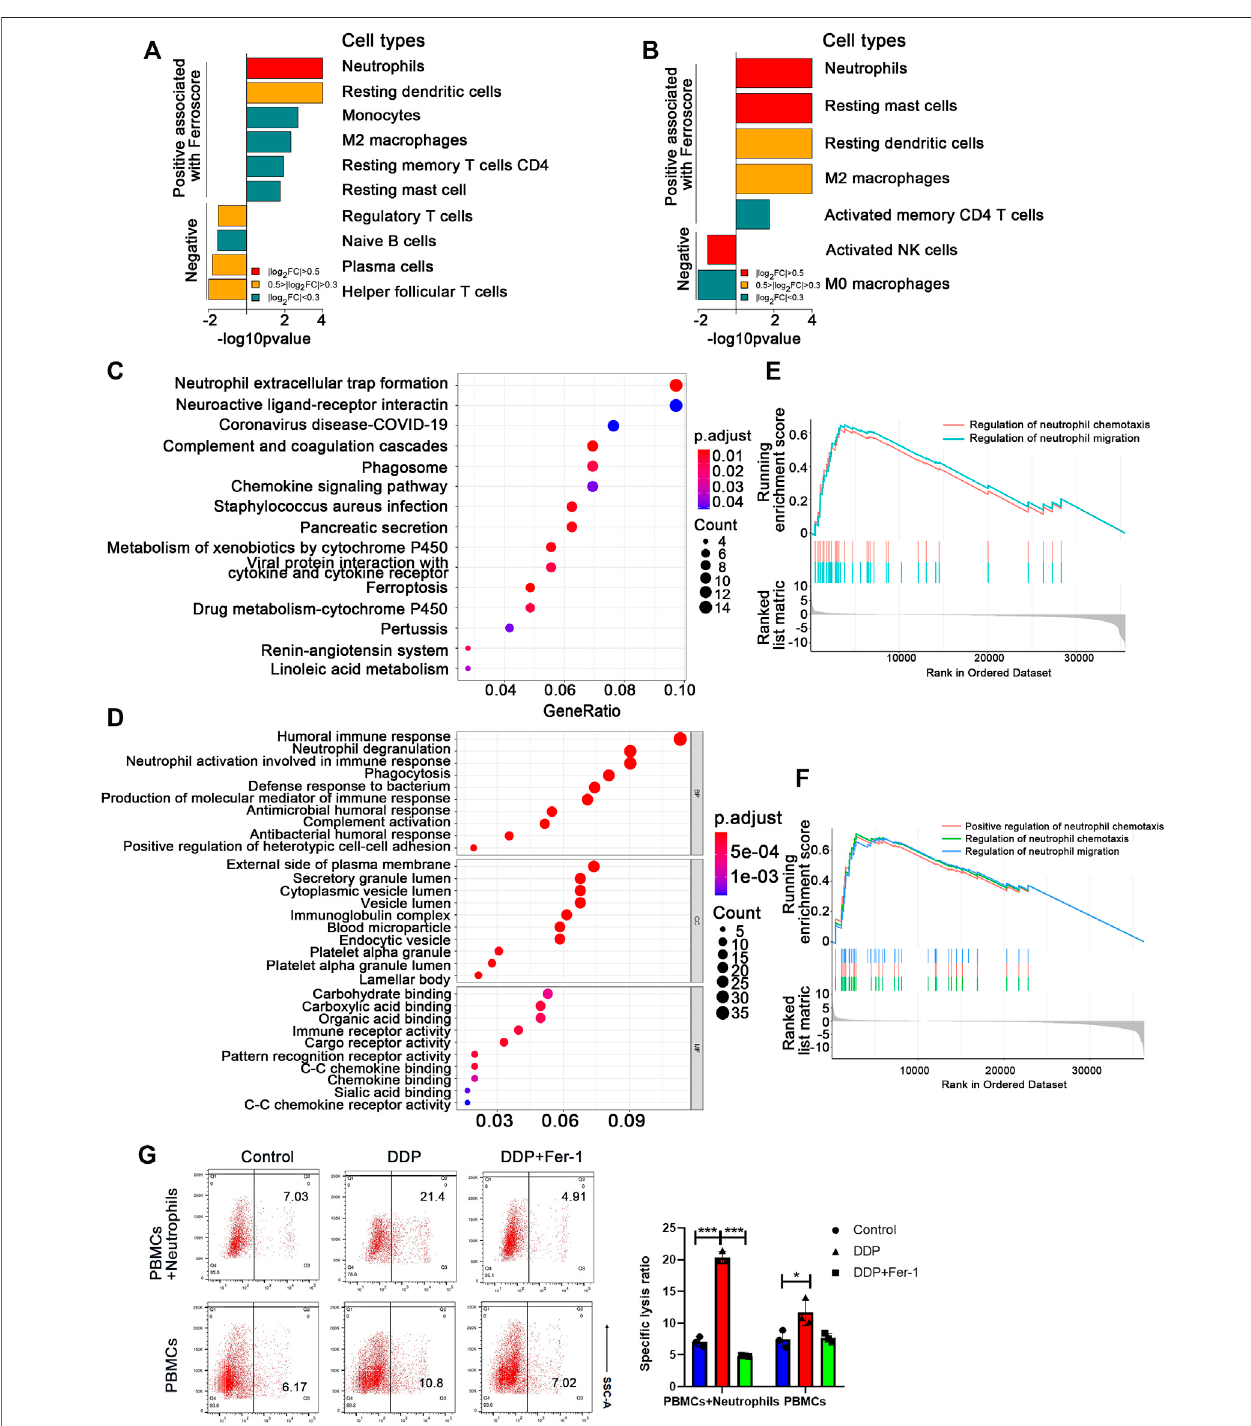
FIGURE2 | Neutrophil activation pathway wassigni fi cantly upregulated in the high ferroscorecohort. (A) and (B) CIBERSORTalgorithms analysisshowed the cell types, positive and negative, associated with ferroscore in LUSC (A) and LUAD (B) cohorts (FC: fold change). (C) and (D) Kyoto Encyclopedia of Genes and Genomes (KEGG) pathway and gene ontology (GO) enrichment analysis of differentially expressed genes between high- and low-ferroscore samples. (E) and (F) Upregulation of neutrophilmigrationorchemotaxis-relatedsignaturegenesinhighferroscoresamplesrelativetolowferroscoresamplesbygenesetenrichmentanalysis(GSEA)in bothLUSC (E) andLUAD (F) cohort. (G) Inthepresenceofneutrophils,DDPpretreatmentsigni fi cantlyincreasedtheA549deathratio,whichcouldberestoredbyFer-1. However, DDP pretreatment failed to induce obvious A549 cell death ratio in the absence of neutrophils. p p < 0.05, ppp p < 0.001.